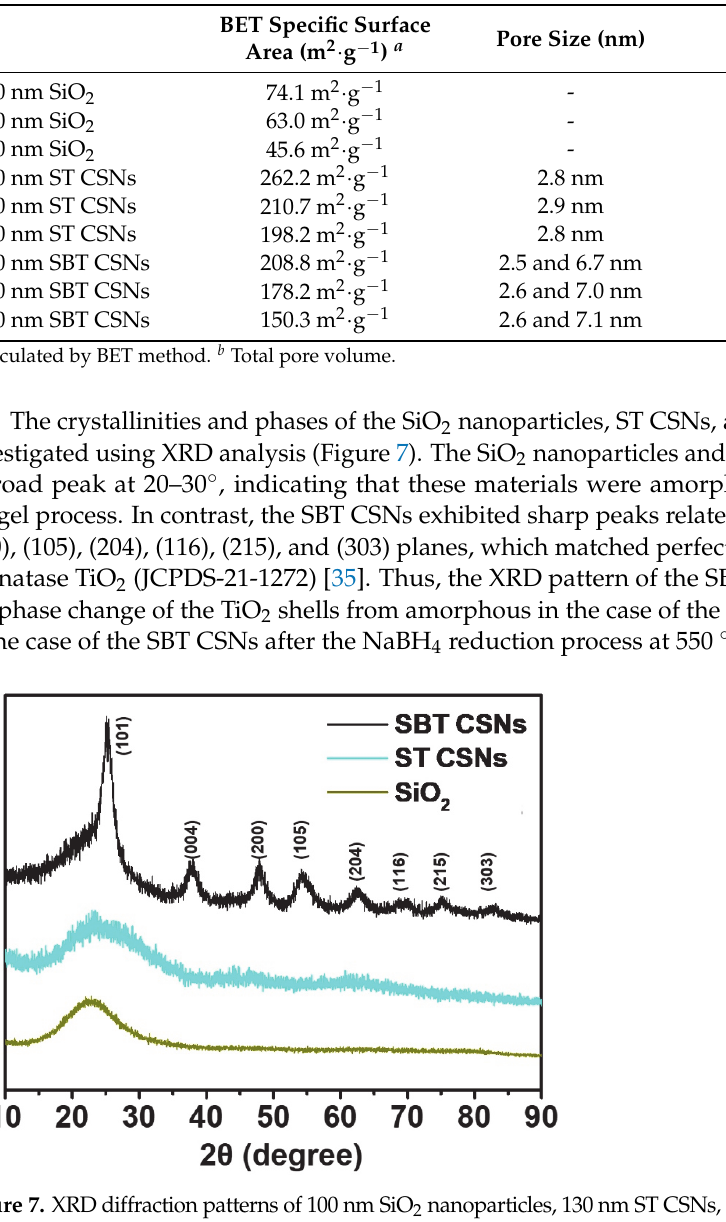
Figure 6. BJH pore size distribution curves of ( a ) 100 nm SiO 2 nanoparticles, ( b ) 130 nm ST CSNs, and ( c ) 140 nm SBT CSNs (inset: N 2 -sorption isotherms of respective materials). For ST CSNs and SBT CSNs, small intrapores ( ca . 2–6 nm) were created within TiO 2 shells. Table 1. BET specific surface areas and pore volumes of various-sized SiO 2 nanoparticles, ST CSNs, and SBT CSNs.